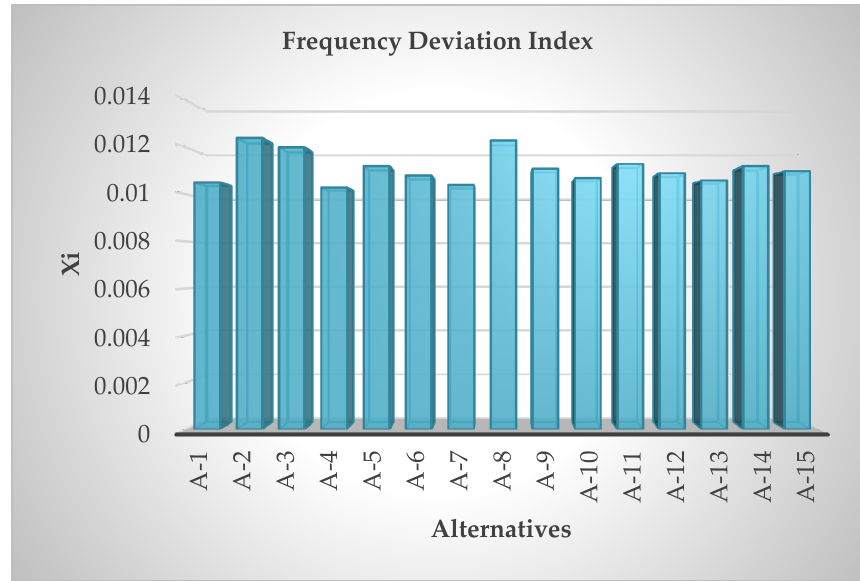
Figure 9. Frequency deviation index of each alternative.